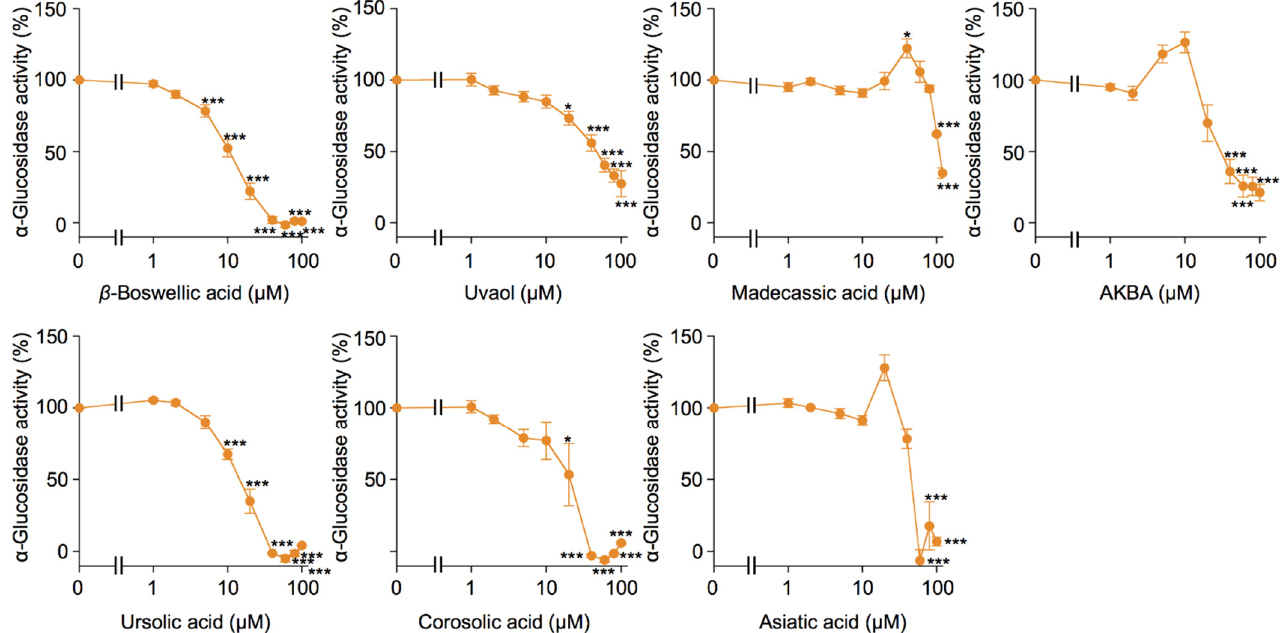
Figure 5. Effects of ursane-type pentacyclic triterpenoids on α -glucosidase activity. Yeast α -gluco- sidase was preincubated with triterpenoids for 30 min, and then incubated with p -nitrophenyl- α - D - glucopyranoside for 15 min in the presence of triterpenoids. α -Glucosidase activity (%) was shown as the mean ± S.E. of three independent experiments. * p < 0.05, and *** p < 0.001.